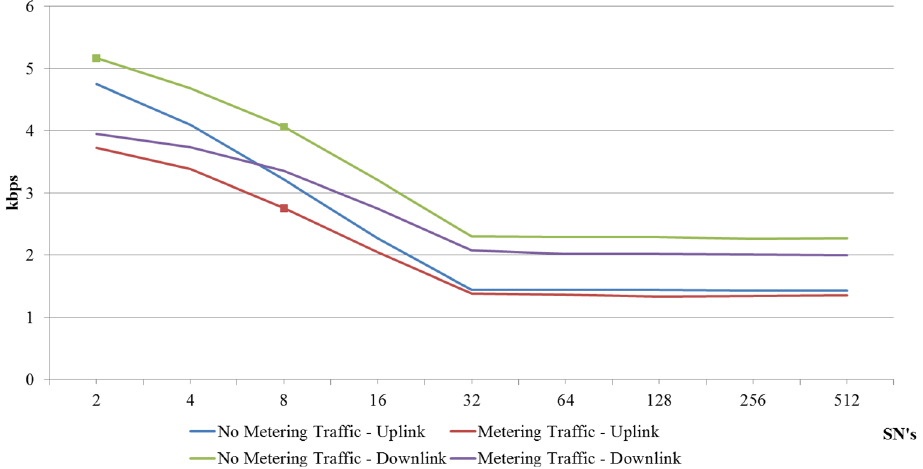
Figure 5. Simulation results validated in the tests plan based on ITU ‐ T G.9904.